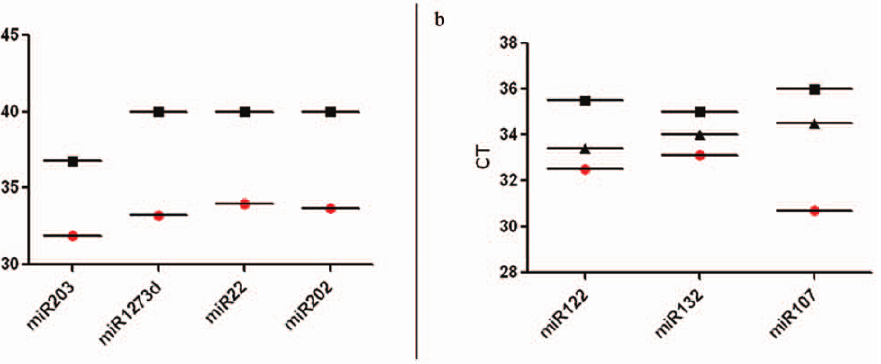
Figure 3. Salivary miRNAs are predominantly in exosomes. ( a ) Absolute differences in microRNA levels amplified from saliva exosome pellet ( # ) and exosome-depleted supernatant ( % ). 1 unit increase in CT represent a two-fold lower amount of miRNA. miRNAs requiring 35 cycles or more are considered undetectable. ( b ) Graph showing the average of three samples in microRNA levels amplified from serum exosome pellet ( # ) and exosome-depleted supernatant ( % ) and whole serum ( n ). Ct value for the whole serum samples was consistently lower (by at least 2 cycles) than the supernatant and at least 1.5 cycles higher than the exosome pellet samples.